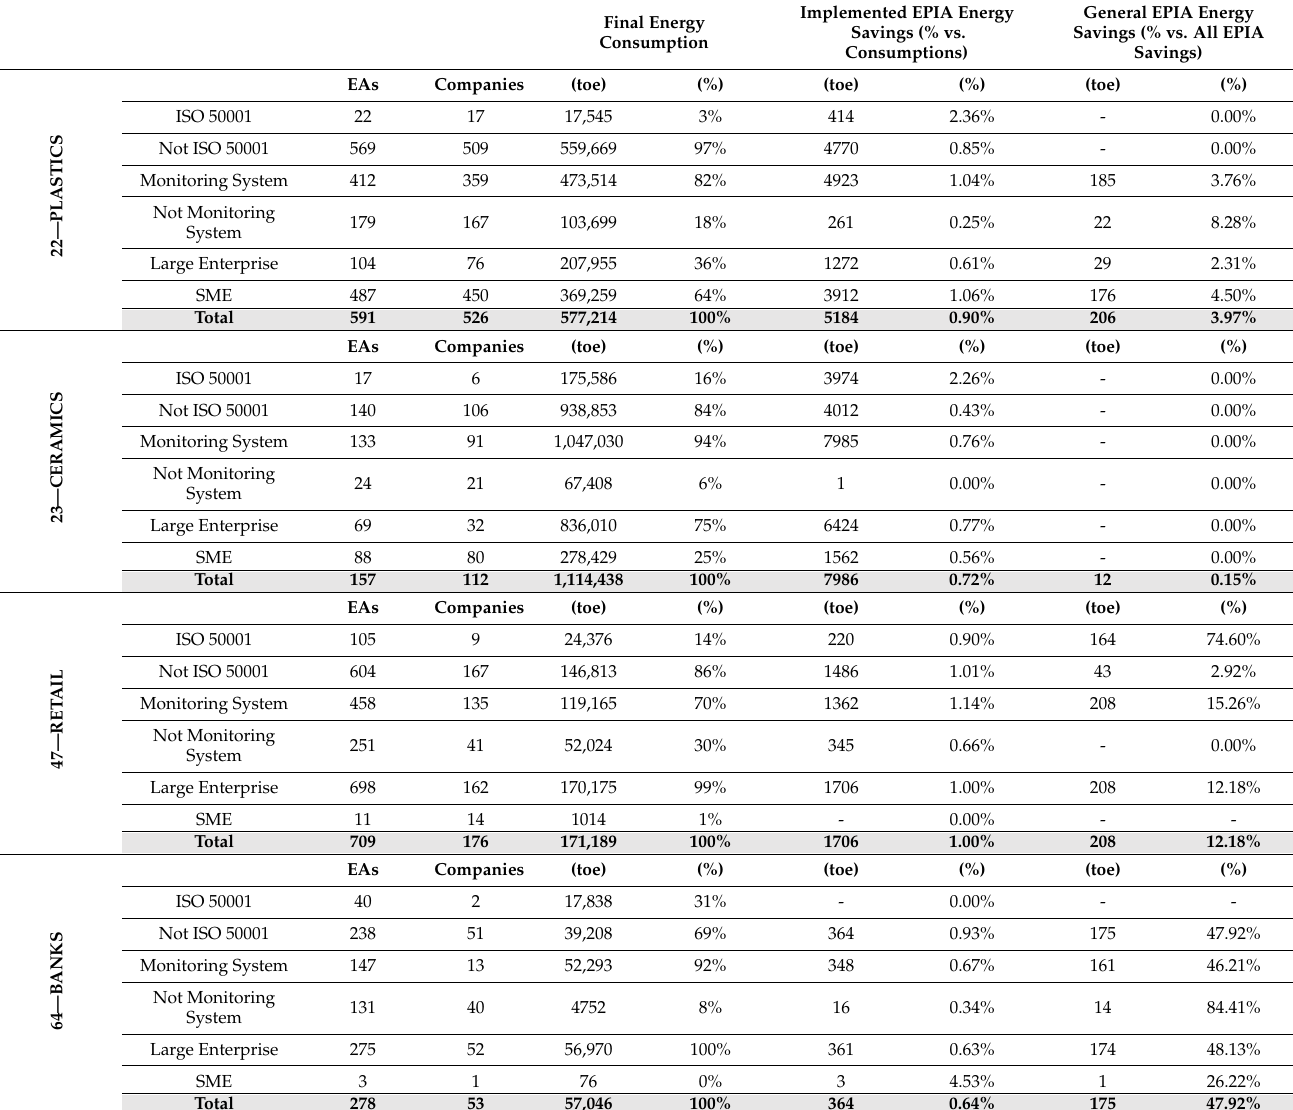
Table A1. Number of EAs and companies; energy final consumption and savings from EPIAs and general EPIAs.